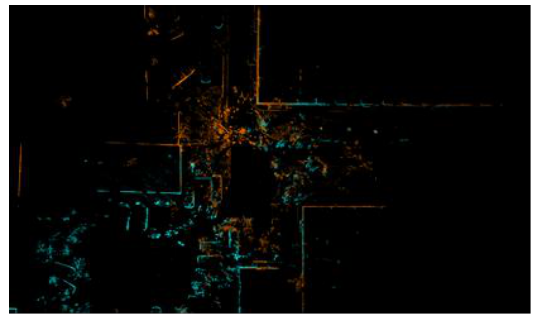
Figure 8. Incompatibility of point cloud